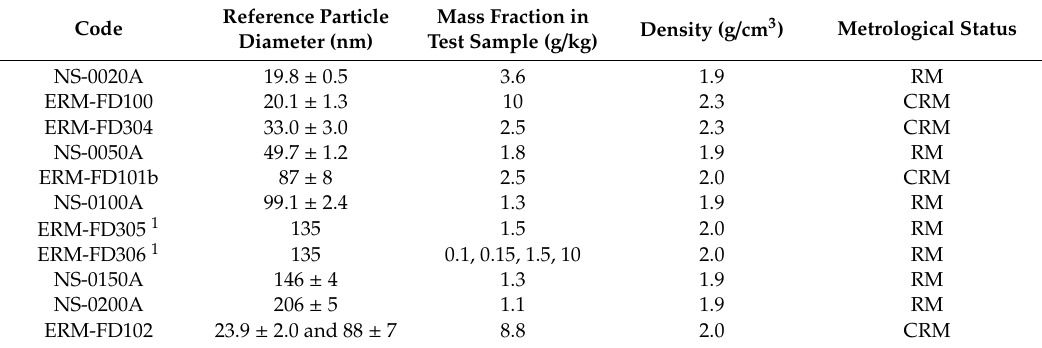
Table 1. Colloidal silica (certified) reference materials used during method development and validation, and their relevant